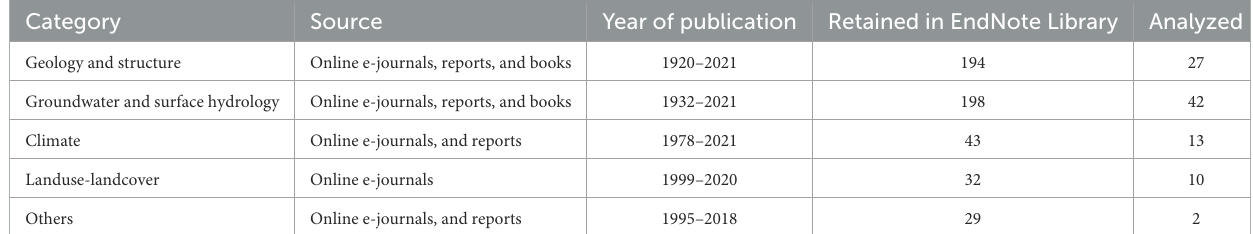
TABLE 1 Overview of collected